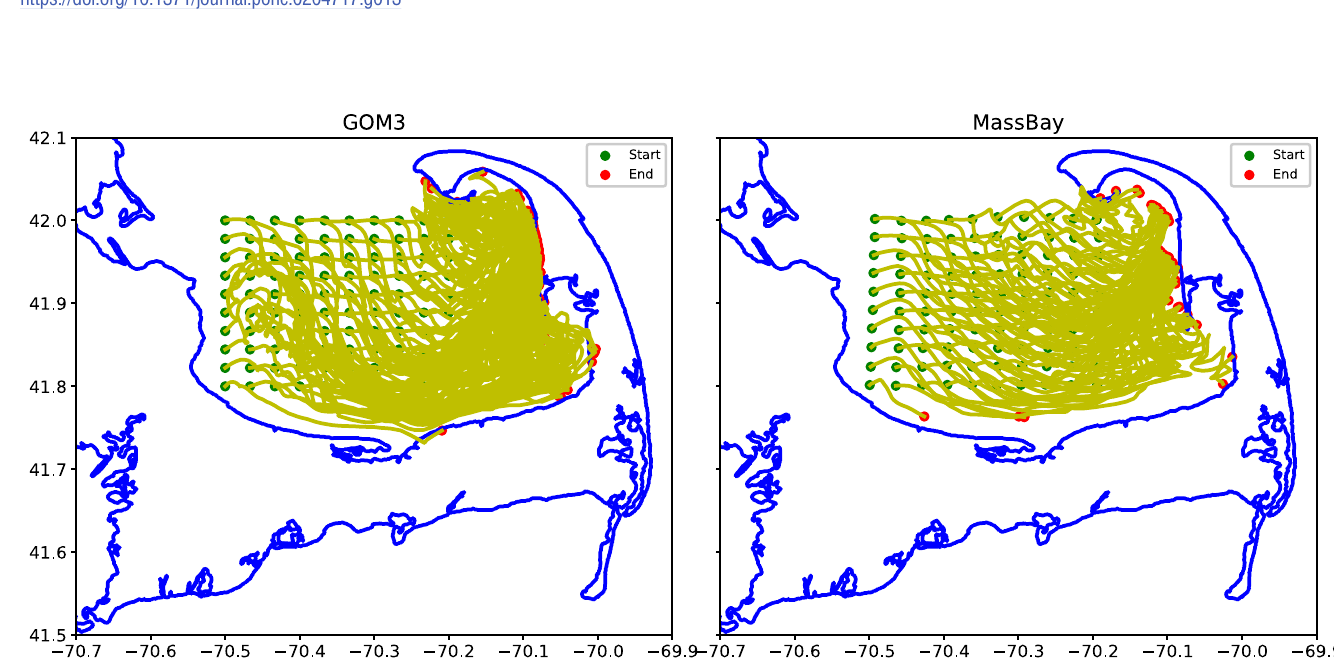
Fig 14. Comparing particle tracks on the GOM3 (left) and MassBay (right) grid during the week of 18–25 Nov 2014.